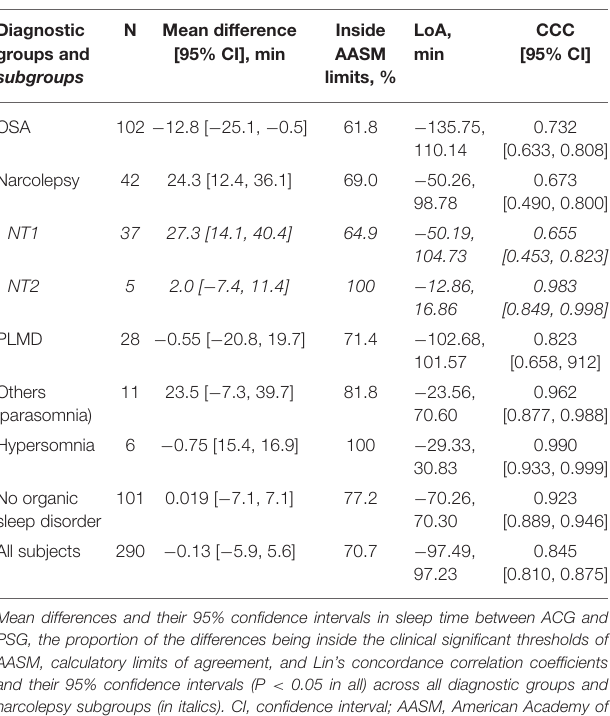
While being very accurate, Bland-Altman plot showed rather wide ( − 97.49, 97.23) limits of agreement (LoA). Non-parametric distribution and outliers increase limits of agreement that are based on the standard deviation of the bias. In the subgroups